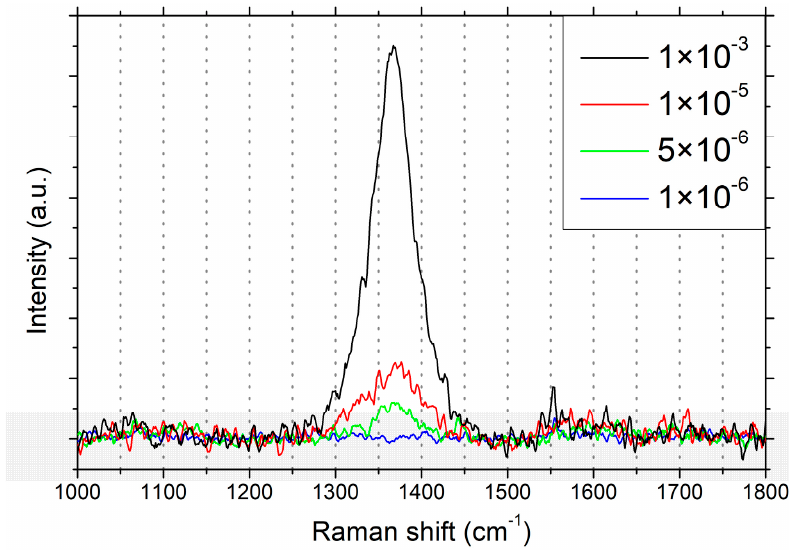
Figure 3. Raman spectra of hBN films grown on Ge(001) at various pressures (in mbar). Generally, the Raman peaks of our hBN films are broad, with a full width at half maxi- mum (FWHM) of 47.0 ± 3.5 cm − 1 , 77.0 ± 1.9 cm − 1 , and 59.1 ± 0.6 cm − 1 for 5 × 10 − 6